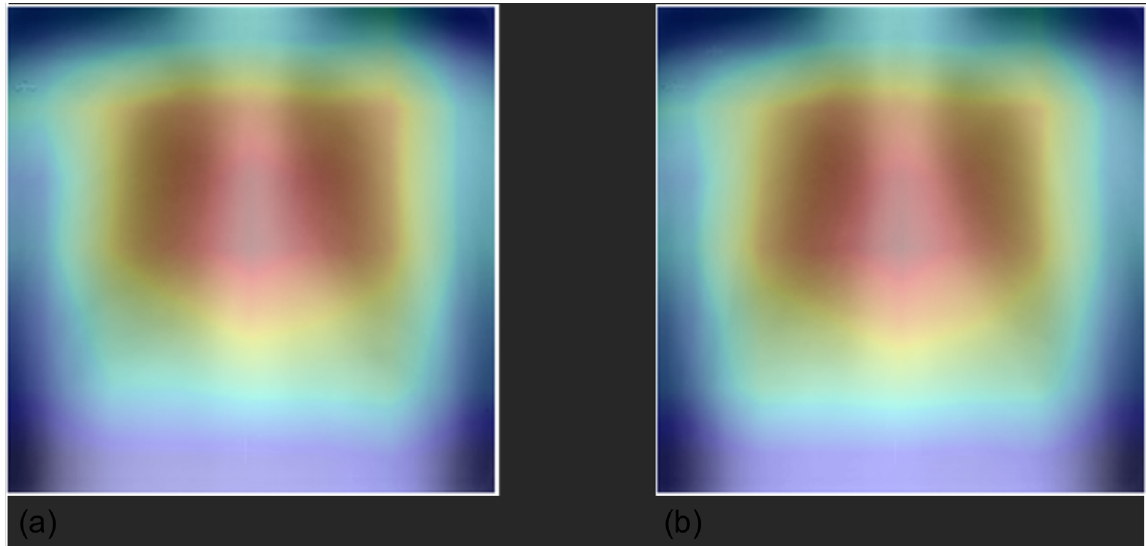
Figure 3. Average of Grad-CAM saliency maps for two batches (panels a , b ) of 200 randomly sampled images. Images confirm that the model focuses on the lung field (image in shades of red and yellow) and does not take into account shortcuts or spurious correlations that could be present in the borders.